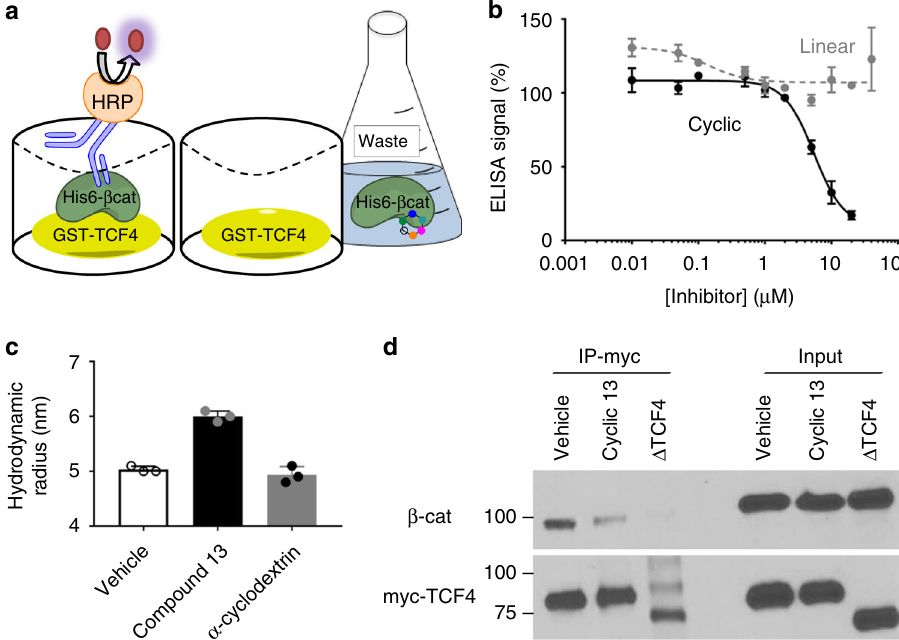
Fig. 3 Macrocycle 13 inhibits the β -catenin:TCF4 interaction. a Schematic for ELISA based detection of recombinant His6- β -catenin binding to a GST-TCF4 N-terminal Catenin Binding Domain fusion protein. b Dose response curves for the cyclic oligomer (black solid line) and linear oligomer (grey dashed line) in the ELISA assay. c Dynamic light scattering measurements of the hydrodynamic radius of β -catenin in the presence of vehicle, compound 13 , or α - cyclodextrin. d Western blot depicting a co-immunoprecipitation (IP) for myc-TCF4 and β -catenin treated with compound. Δ TCF4: A myc-TCF4 construct that lacks the β -catenin binding domain. Data are presented as mean and SD ( n = 3) of three independent experiments ( c ) or representative of three independent experiments ( b , d